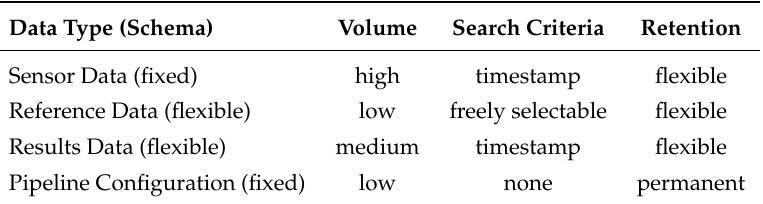
Table 3. Data Types and their